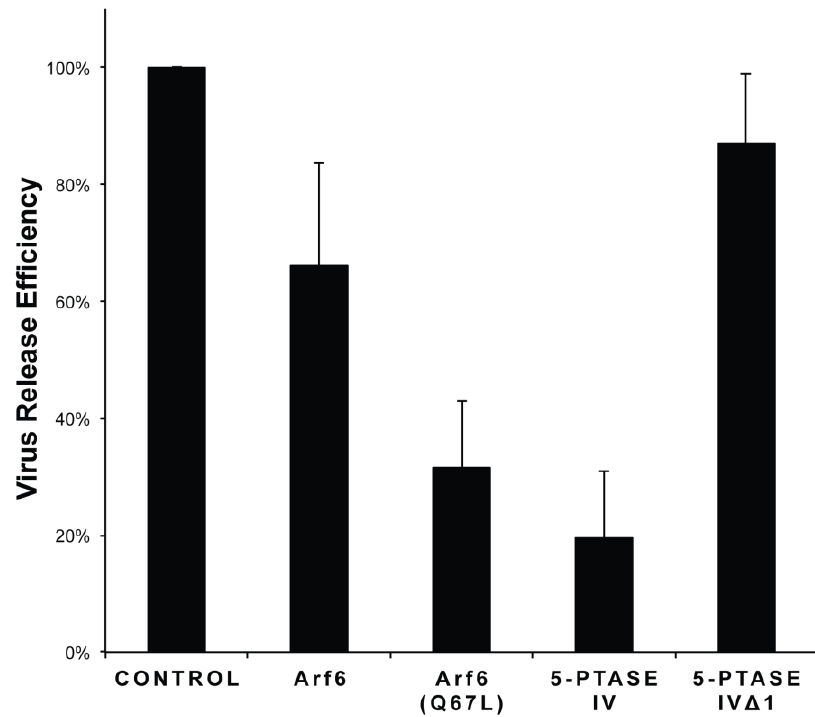
Figure 7. PI(4,5)P 2 disruption impairs FIV particle production. Feline CRFK cells were co-transfected with pFIV-Orf2rep and plasmids expressing human Arf6 in either its native or constitutively active form (Q67L) or human 5-phosphatase-IV (5ptaseIV) in its native or catalytically inactive form (5ptase Δ1) using Lipofectamine LTX PLUS reagent (Invitrogen), at a DNA ratio of 9:1 (FIV:Arf6/5ptaseIV). Cells were metabolically labeled with [ 35 S] Met/Cys and FIV proteins were immunoprecipitated from cell and viral lysates with anti-FIV p24gag (see Materials and Methods). Virus release efficiency was calculated as the proportion of virion-associated FIV capsid compared with total FIV Gag, normalized to samples containing FIV plasmid alone. Error bars indicate standard error of the mean (SEM) from at least 3 independent experiments. Reductions in virus release in the presence of Arf6/Q67L and 5ptaseIV were statistically significant (paired Student’s t